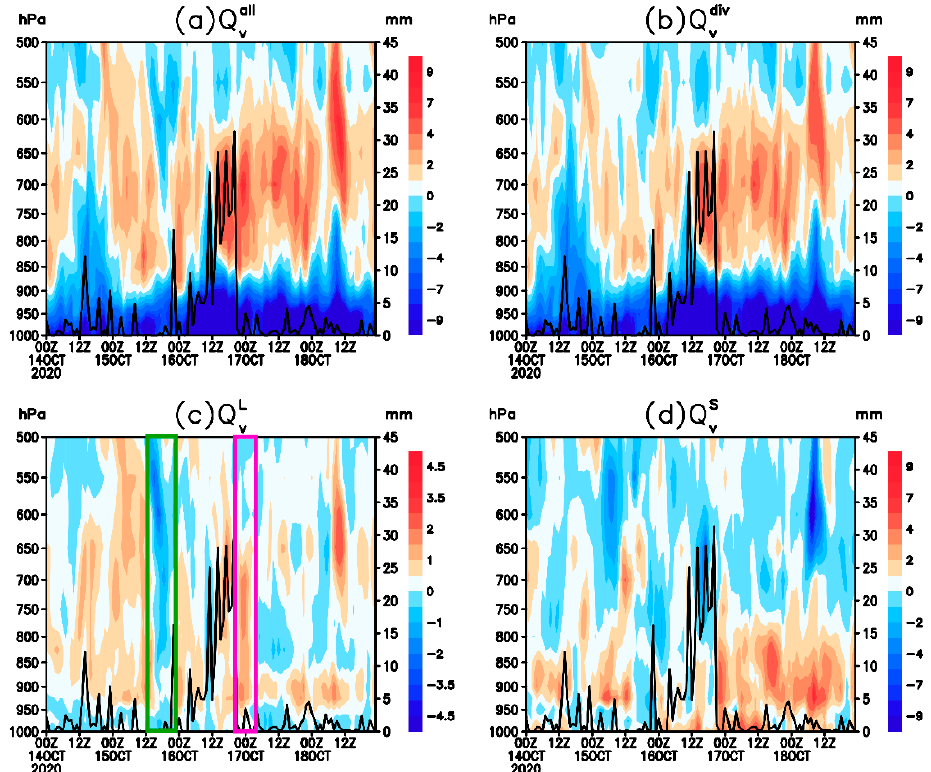
Figure 5. Pressure-time cross sections of domain averaged ( a ) Q vall , ( b ) Q vdiv , ( c ) Q vL (shaded, units: 10 − 7 g · hPa − 1 · cm − 2 · s − 1 ), and ( d ) Q vS (d, shaded, units: 10 − 8 g · hPa − 1 · cm − 2 · s − 1 ) over the southeast coast (green rectangle in Figure 1d) superimposed with hourly precipitation (units: mm · h − 1 ), for Wanning (green triangle in Figure 1d).